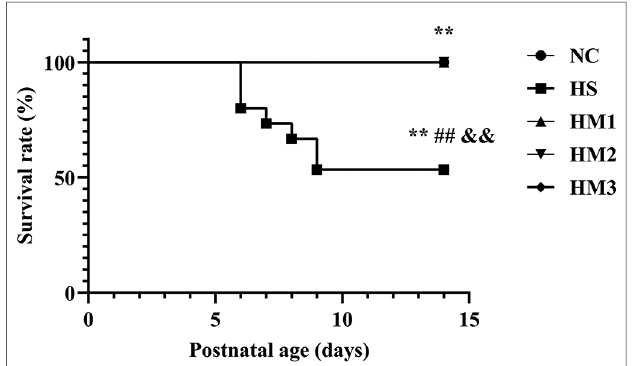
FIGURE 3 Human umbilical cord-derived mesenchymal stem cells (hUC-MSCs) improves survival rate of each group at postnatal day (PN) 14 showed in Kaplan-Meier survival curves. All the rat pups reared in the NC group ( n =14) and those reared in hyperoxia treated with human umbilical cord- derived mesenchymal stem cells (hUC-MSCs) (HM1, HM2, and HM3 groups) ( n =14 – 16) survived. The rat pups reared in the HS group ( n = 14) had a signi fi cant reduced survival rate than did those reared in the NC group. hUC-MSCs improved the hyperoxia-induced decrease of survival rate, and the differences among the groups were statistically signi fi cant. **, ##, and && P <0.01.